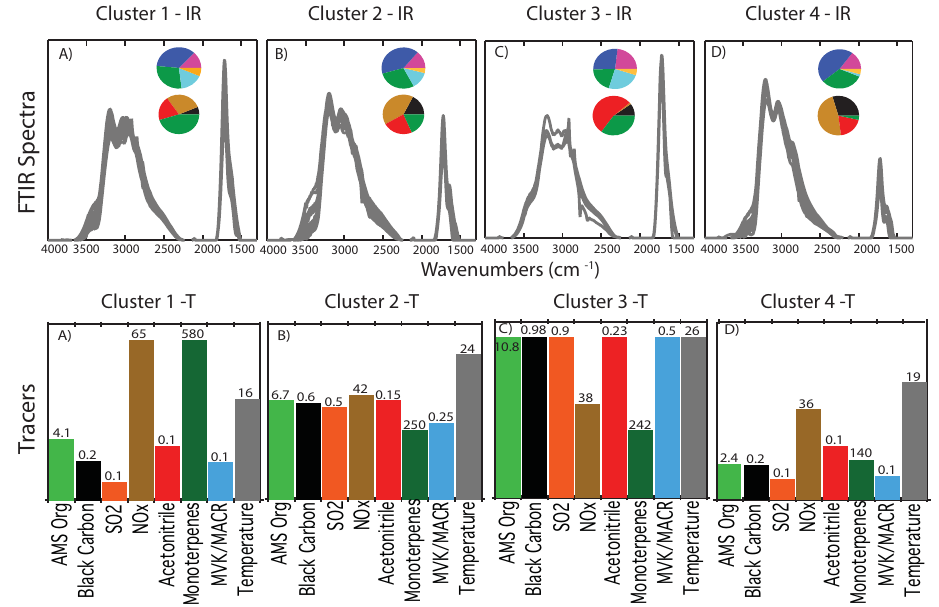
Fig. 2. (Top) FTIR spectral clusters from Ward algorithm (A) Cluster 1 – IR (23 spectra), (B) Cluster 2 – IR (22 spectra), (C) Cluster 3 – IR (5 spectra), and (D) Cluster 4 – IR (11 spectra). Top pie chart in each panel shows average organic functional composition for each cluster: alcohol (pink), alkane (blue), carboxylic acid (green), nonacid carbonyl (teal), and primary amine (orange). Bottom pie chart in each panel represents the average contribution of each FTIR PMF factor in each of the four clusters: FFC1 FTIR (black), FFC2 FTIR (tan), BB FTIR (red), and BIO FTIR (green). (Bottom) Clustering of organics, gas phase, particle phase, and meteorological data. (A) Cluster 1-T, high monoterpenes (580ppt) and NO x (65ppb). (B) Cluster 2-T, low organics (6.7µgm − 3 ). (C) Cluster 3-T, high organics (10.8µgm − 3 ), SO 2 (0.9ppb), MVK/MACR (0.5ppt), and temperature (26 ◦ C). (D) Cluster 4-T, low organics (2.4µgm − 3 ) and moderate temperatures (19 ◦ C). Cluster averages of each tracer are normalized to the maximum value of each tracer to show relative differences between cluster groups. Average values of each tracer are listed on the bar plot: AMS organics and black carbon (µgm − 3 ), SO 2 , NO x , and acetonitrile (ppb), monoterpenes and MVK/MACR